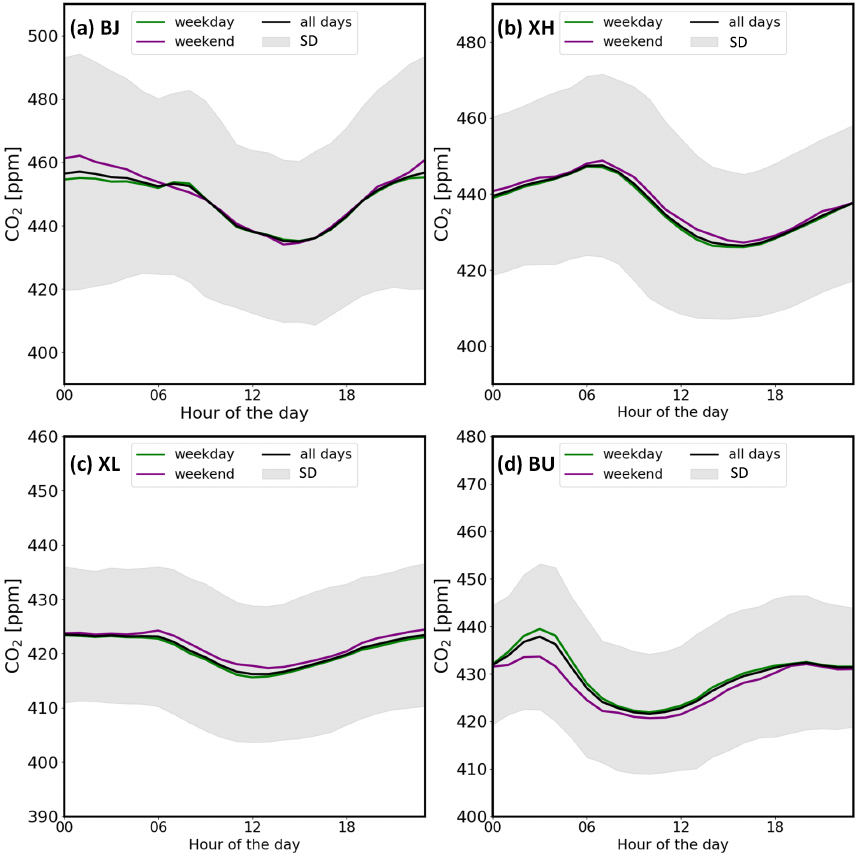
Figure 13. The average hourly means of CO 2 on weekdays, weekends, and all days at (a) BJ (L1), (b) XH (L1), (c) XL, and (d) BU (Boston) between October 2018 and September 2019. The light gray shaded area represents 1 standard deviation from the mean for all